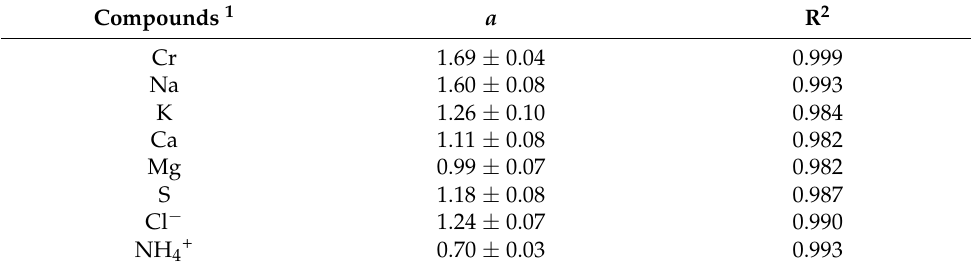
Figure 4. Mass ratio of each compound in retentate during diafiltration with a cs-PES MF022 mem- brane at 20 bar. Mass ratio was calculated in reference to the total mass of the same compound, M i,x , in the SW30 concentrate of a synthetic tannery effluent before diafiltration (diafiltration feed solution). Note that the electric charge of the elements quantified by ICP-AES was omitted, as this technique quantifies the total amount of the element in the solution independently of its electric charge. Table 3. Fitting parameters to the exponential decay of the mass removal for different compounds in the diafiltration retentate: a corresponds to the exponential term, whereas the fitting quality is expressed by the respective R 2